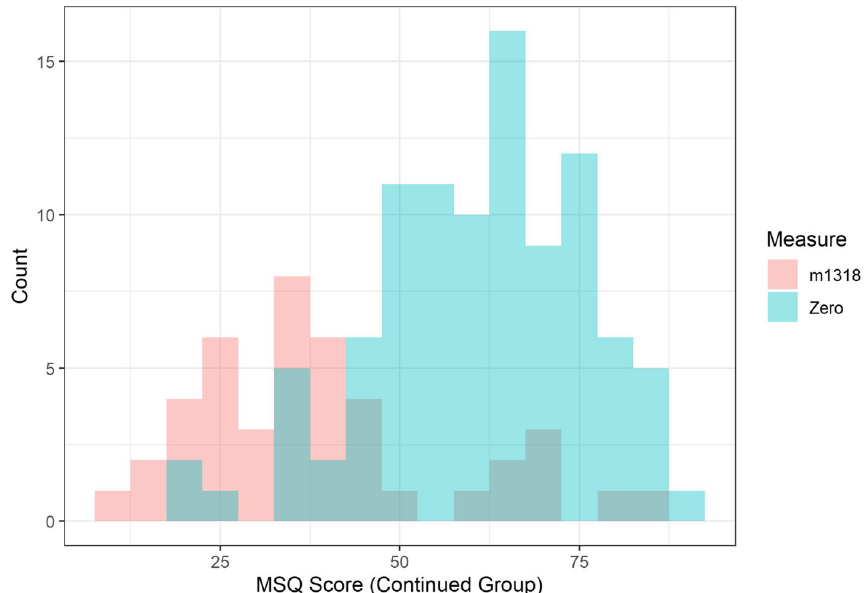
Fig. 6 Histogram comparing times Zero and m1318 distribution of MSQ scores for patients who remained on treatment beyond June